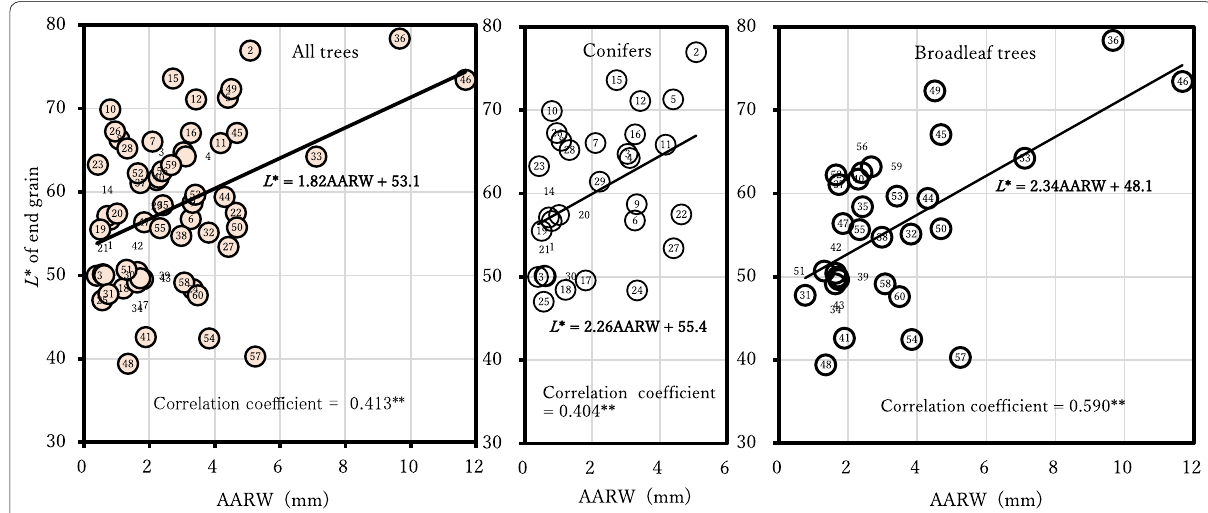
Fig. 10 Correlation diagrams between AARW and L* of end grain of each test piece. Each test piece number is shown as in Tables 1 and 3. Significance test results of correlation coefficient ** p <